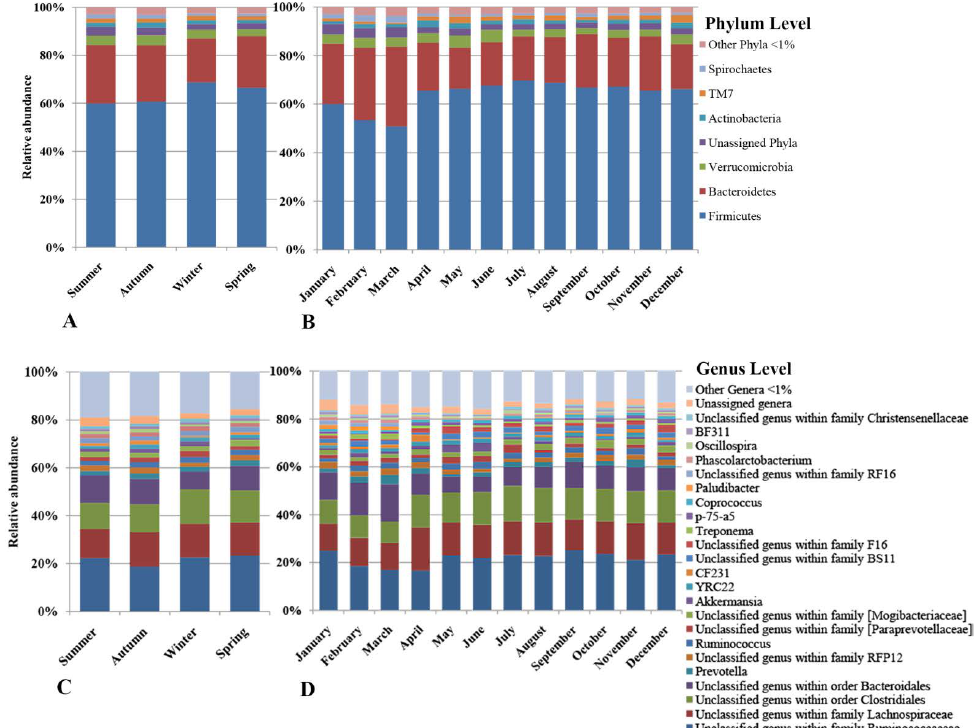
Figure 6. Comparison of relative abundances of the faecal bacteria of horses included in the study. The relative abundances of the bacterial community are presented at phylum and genus levels. The stacked bar charts in panels ( A , C ) show the relative abundances by seasons, and panels ( B , D ) show the relative abundances by month. Phyla and genera with mean relative abundances of <1% were categorised as other phyla <1% or other genera <1%.